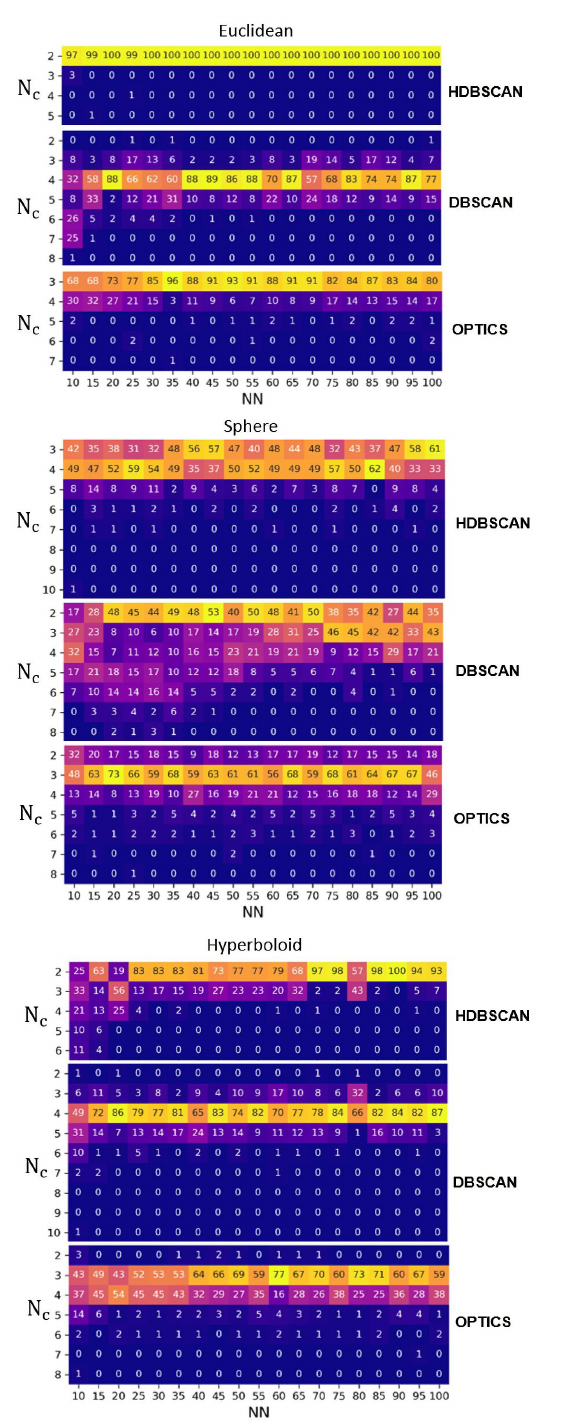
Figure 3. Variability of the number of clusters (N c ) estimation. Absolute frequency of the N c obtained from implementing HDBSCAN, DBSCAN, OPTICS in T = 100 iterations on UMAP embeddings. NN ranging from 10 to 100, for Euclidean, spherical, and hyperbolic space. A lighter color (yellow) indicates a higher frequency value, while a darker color (blue) indicates a lower, tending to zero, frequency value. We did not report N c of the agglomerative clustering since it is fixed a